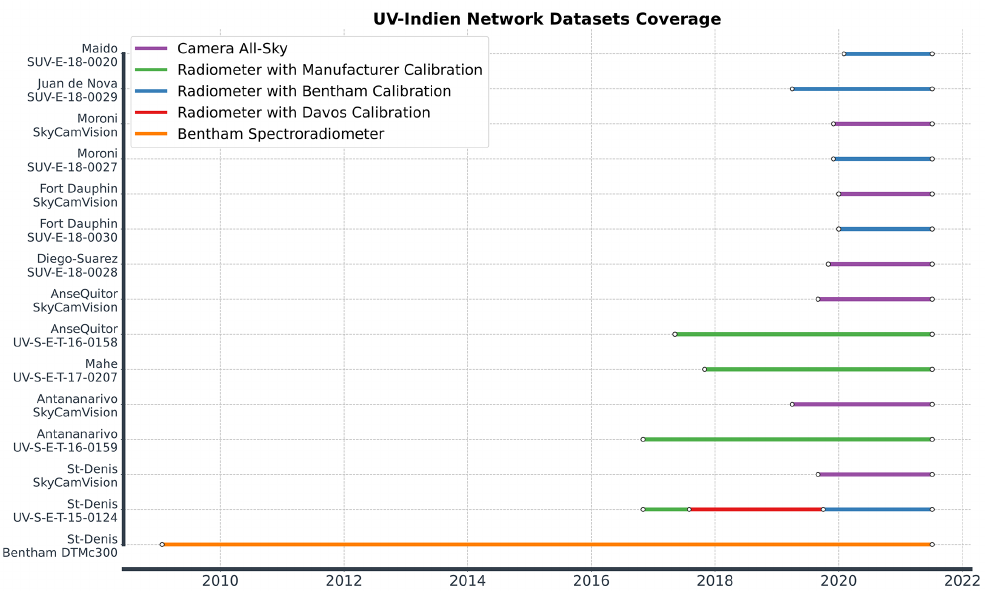
Figure 2. Timeline of the instruments of the UV-Indien network. The measurement periods of the cameras are shown in purple. The measure- ment period of the Bentham spectroradiometer is shown in orange. The measurement periods of the radiometers that are either manufacturer- calibrated, Davos-calibrated, or Bentham-calibrated are shown in green, red, and blue,